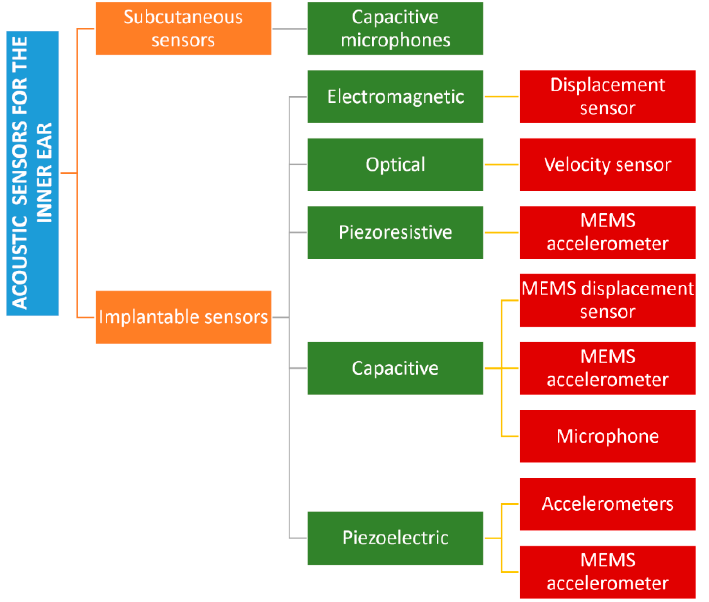
Figure 5. Classification of the acoustic sensors for hearing aids based on the implantation site and the final application.